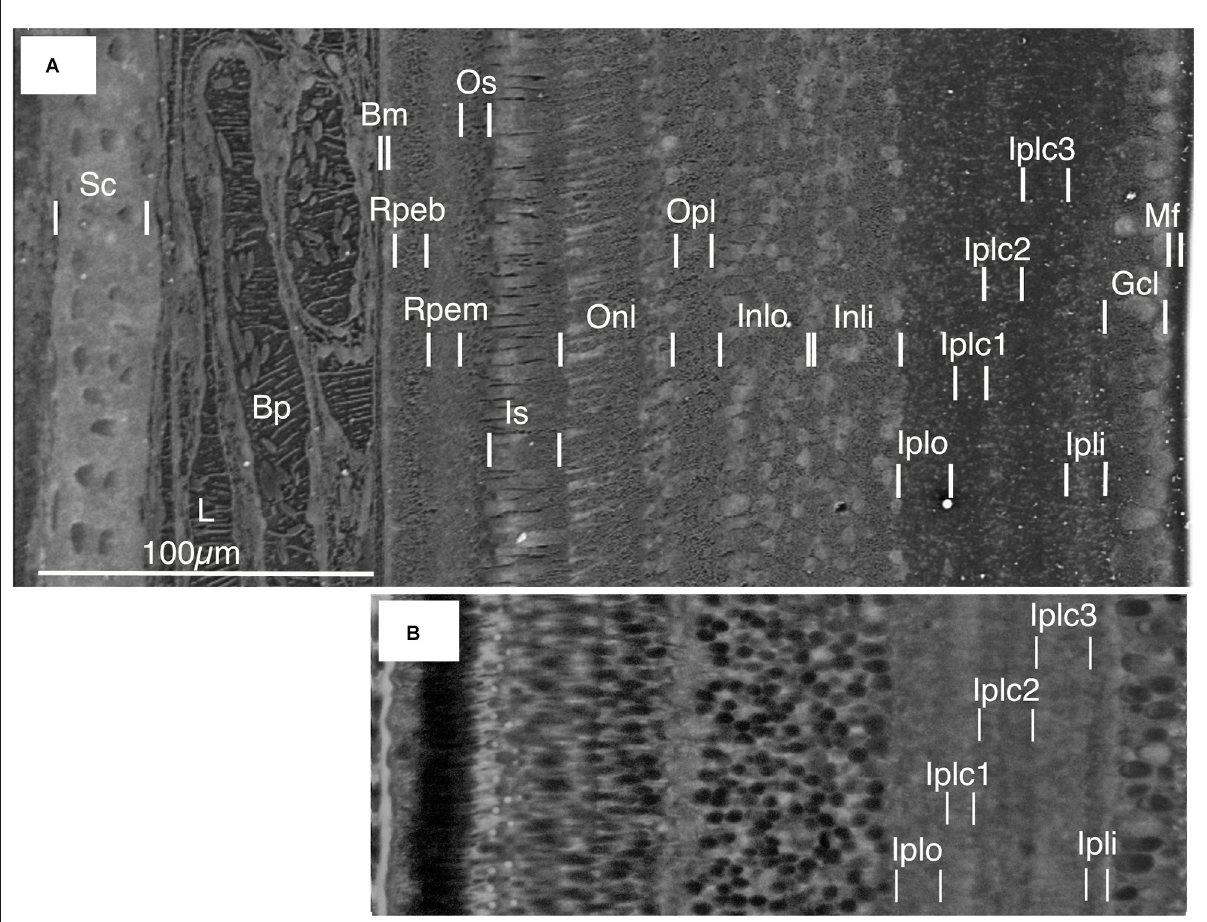
FIGURE3 (A) Frozen-hydrated retinal complex showing cell and tissue layers. Sc, sclera; L, frozen lymph within the lymphatic vessel; Bp, frozen blood plasma within blood vessel containing erythrocytes; Bm, Bruch’s membrane, Rpeb, basal region of the RPE (retinal pigment epithelium); Rpem, apical melanosome-containing region of RPE; Os, outer segment region of photo receptors; Is, inner segment of photoreceptors; Onl, outer nuclear layer; Opl, outer plexiform layer; Inlo, inner nuclear layer outer region; Inli, inner nuclear layer inner region; Iplo, inner plexiform layer outer layer; Iplc1, inner plexiform layer central layer 1; Iplc2, inner plexiform layer central 2; Iplc3, inner plexiform layer central 3; Ipli, inner plexiform layer inner layer; Gcl, ganglion cell layer; Mf, Muller cell feet and nerve layer. (B) Stained semithin section of freeze-substituted retina and RPE. The cell layers correspond to those in the frozen-hydrated retinal complex in (A)